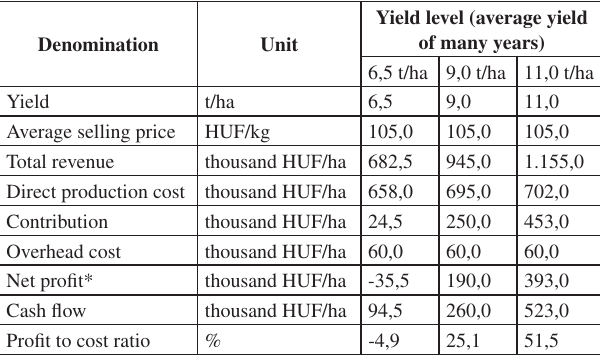
Table 3: Revenue, Profit and Profitability of the Elderberry Orchard Cultivated on a Good Standard Relating to the Whole Productive Years, in Case of Different Yield Levels